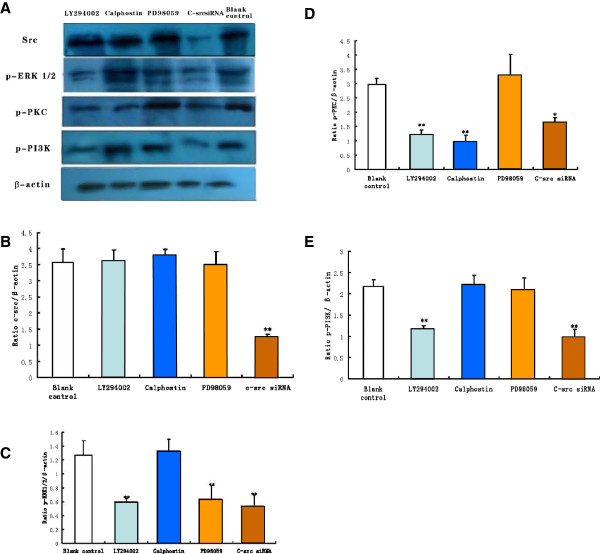
The expression of Src, p-ERK1/2, p-PKC and p-PI3K protein afterc-srcsiRNA, PD98059, Calphostin and LY294002 treatment, respectively.A,The expression of Src, p-ERK1/2, p-PKC and p-PI3K protein in the ovaries detected by western blotting. B, The expression of Src protein according to a semiquantitative analysis of the western blot result. C, The expression p-ERK1/2 protein according to a semiquantitative analysis of the western blot result. D, The expression of p-PKC protein according to a semiquantitative analysis of the western blot result. E, The expressions of p-PI3K protein by semiquantitative analysis of the western blot result. Blank control corresponds to the group transfected with negative control siRNA. The data are presented as the means ± SEM (n = 3). ** P<0.01 vs. blank control group.